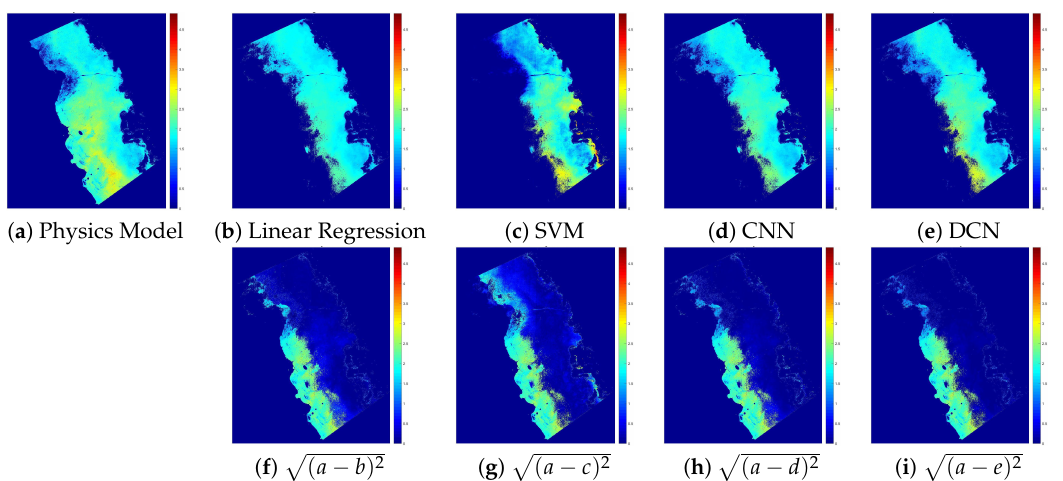
Figure 6. LAI mapping at Keeton Beach produced by models trained with patches from the selected regions. The LAI maps are masked to show only those pixels that are classified as seagrass by the capsule